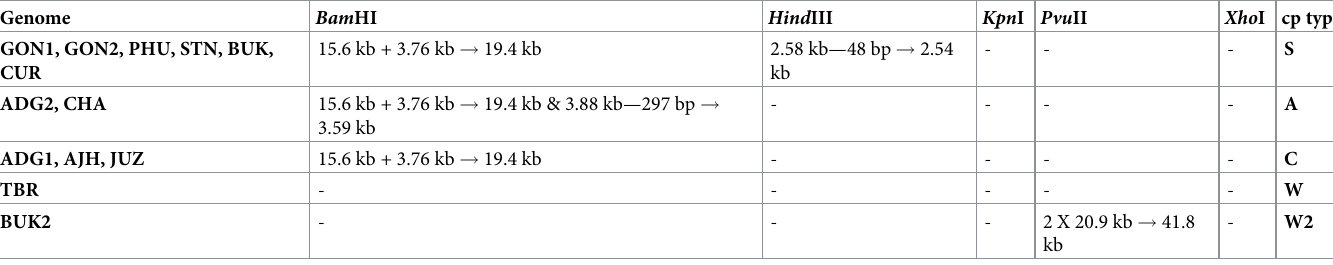
Different polymorphisms were observed in fragment lengths when digested with five restriction enzymes. These length polymorphisms were compared with previous studies to identify plastome types [1, 10]. The RFLP analysis confirms the findings from the marker analysis and also identify the types of ADG2, CHA, BUK2, and